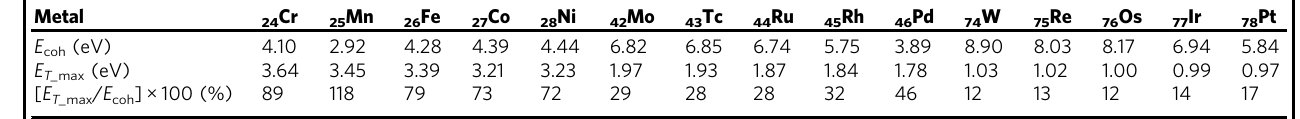
Table 1 Comparison of energy transferred to metal with strength of metallic bonding Metal